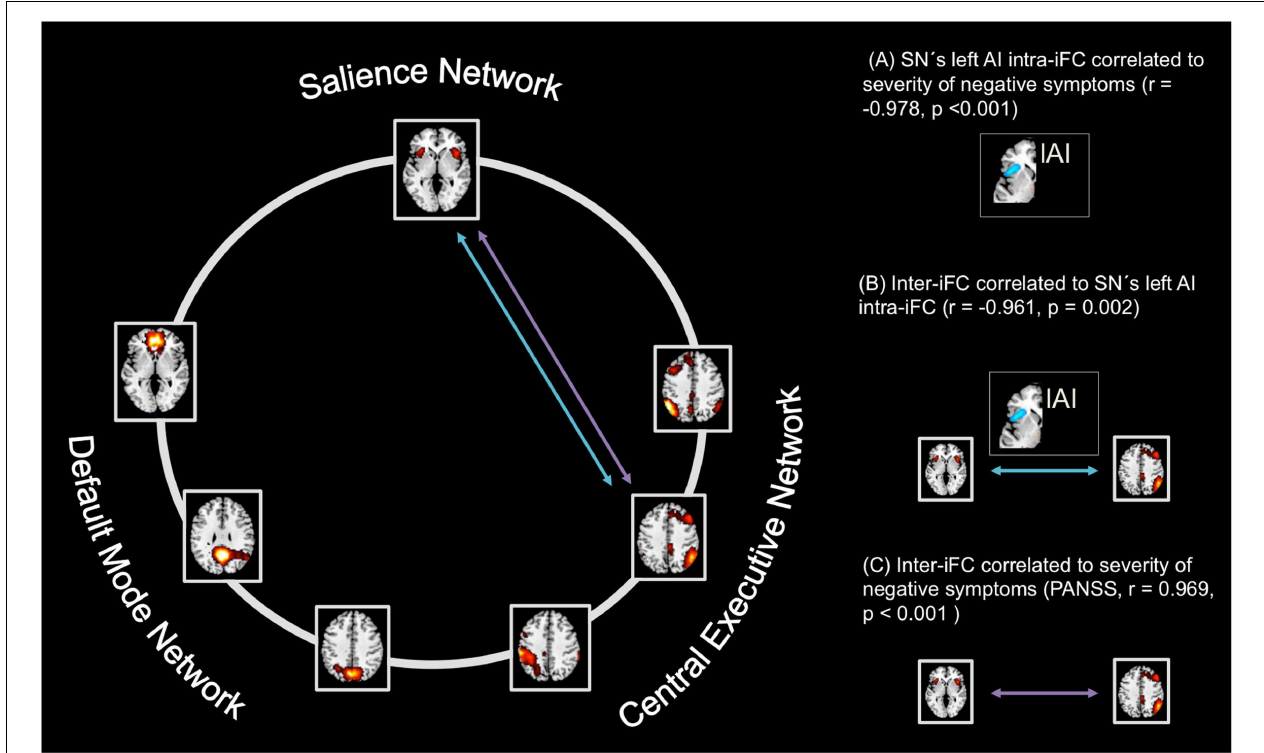
with the inter-iFC between SN and CEN in patients (turquoise arrow, partial correlation, r =− 0.961, p = 0.002). (C) Finally, the inter-iFC between SN and CEN was significantly correlated with the severity of negative symptoms (purple arrow, partial correlation, r = 0.969, p < 0.001). All partial correlations were corrected for age, sex, total GM volume, and medication (CPZ). Spatial maps indicate the anterior/inferior-posterior/superior-posterior default mode network (a/ip/spDMN), left-ventral/right-ventral/dorsal central executive network (lv/rv/dCEN), and salience network (SN) (see also Tables 6 – 8